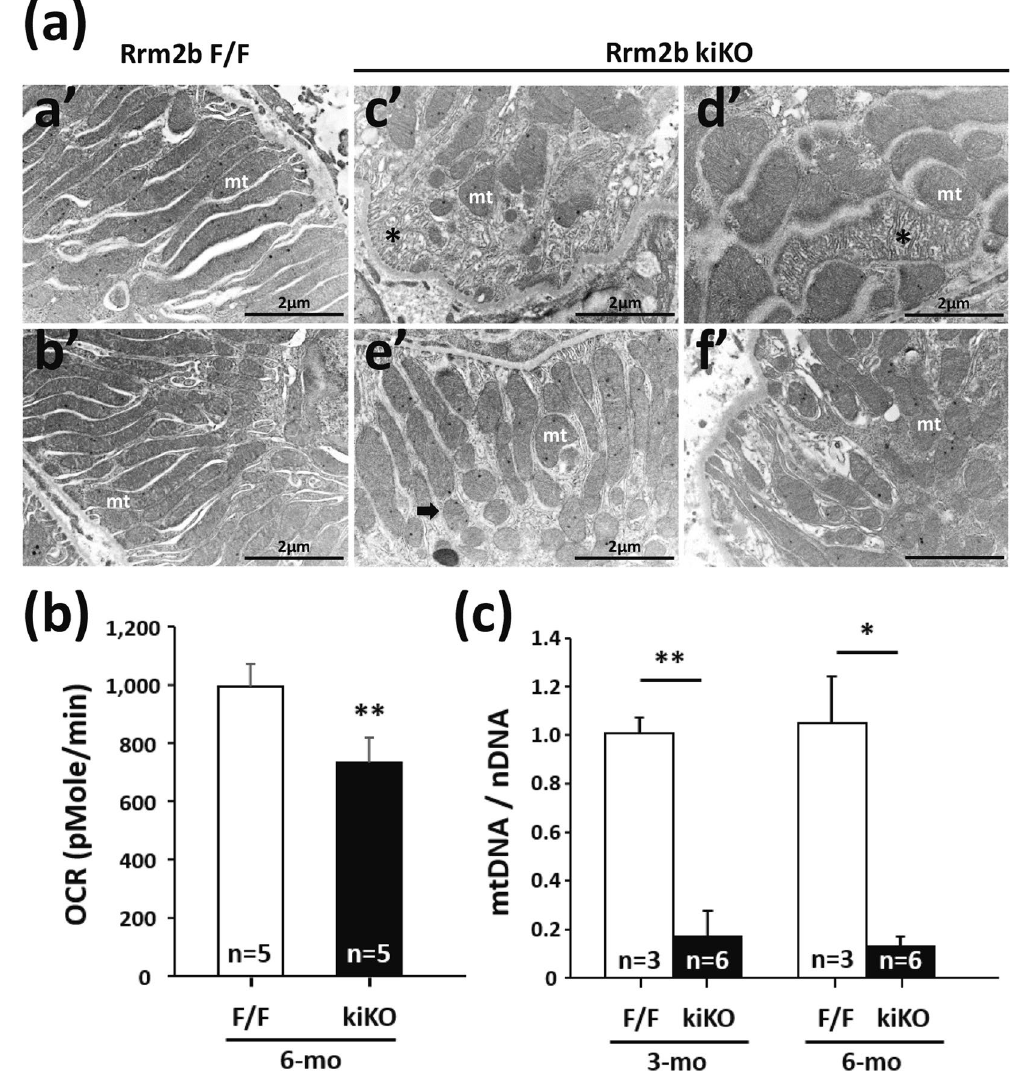
Figure 3. Mitochondria defects in Rrm2b kidney-specific knockout mice. ( a) Ultrastructure of kidney cortex. (a’,b’) Numerous elongated mitochondria (mt) were located in proximity to the plasma membrane of cell in wild-type proximal tubule. (c’–f’) Fragmented (arrow head) and degenerated (asterisk) mitochondria were found in the proximal tubules of Rrm2b deleted kidney. Mouse age, 3 months old. (b) Analysis of the efficiency of oxygen consumption in kidney cortex from 6-month-old mice. (c) Mitochondrial DNA ( mt-Co2 ; mitochondria-encoded gene; mtDNA) was measured relative to 18S rRNA (nucleus-encoded gene; nDNA) as the control. The results are presented as the mean ± SD. * p < 0.05; ** p <